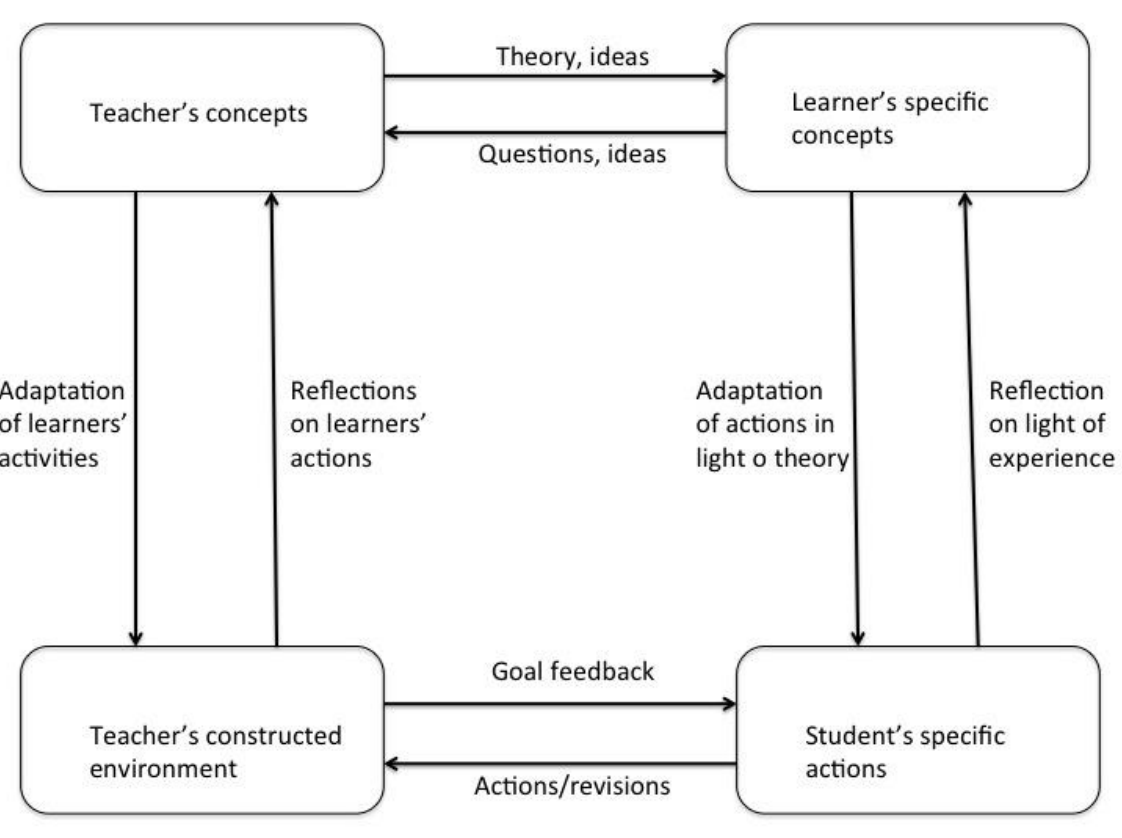
Figure 2: Adapted from Laurillard's Conversational